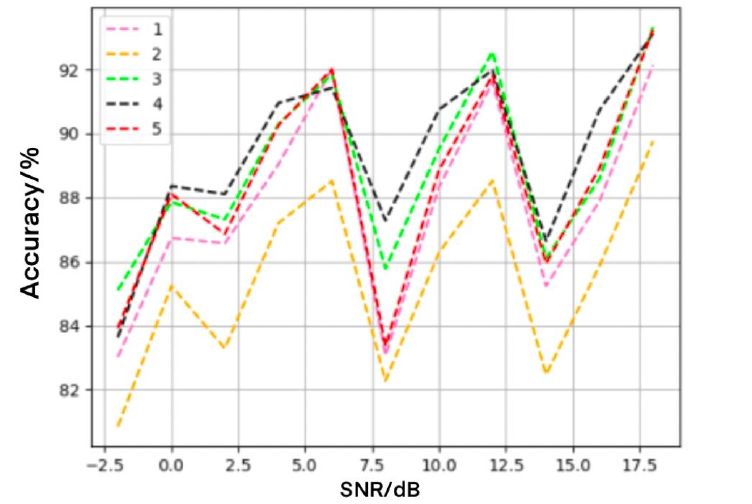
Figure 7. Effect of different convolution layers on recognition rate.